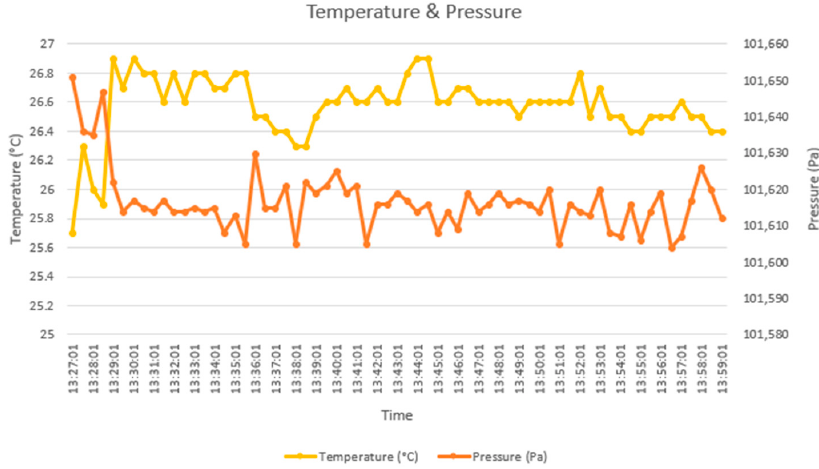
Figure 11. Evolution of temperature and pressure monitored by the sensing module prototype in the admission office.